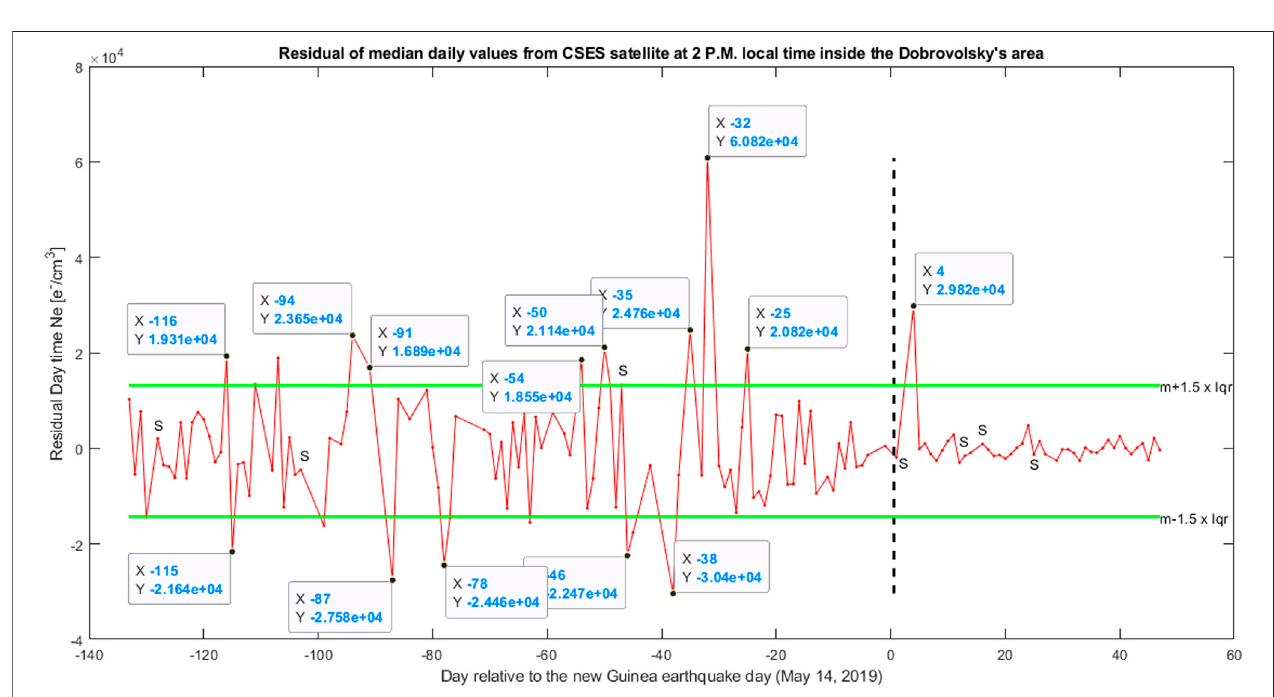
FIGURE12| CSESdailymedian electron density duringday time(2:00 p.m.). Onlydataacquired duringgeomagneticquiettime(|Dst| ≤ 20nTanda p ≤ 10 nT)has been shown. Days with high solar activity are depicted by “ S. ”